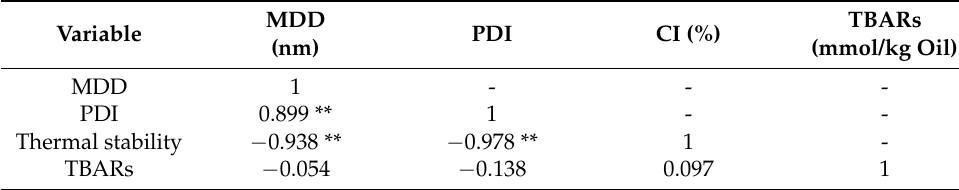
Table 4. Pearson’s correlation coefficients between mean droplet diameter (MDD), polydispersity index (PDI), creaming index (CI) and thiobarbituric acid reactive substances (TBARs) of conventional and